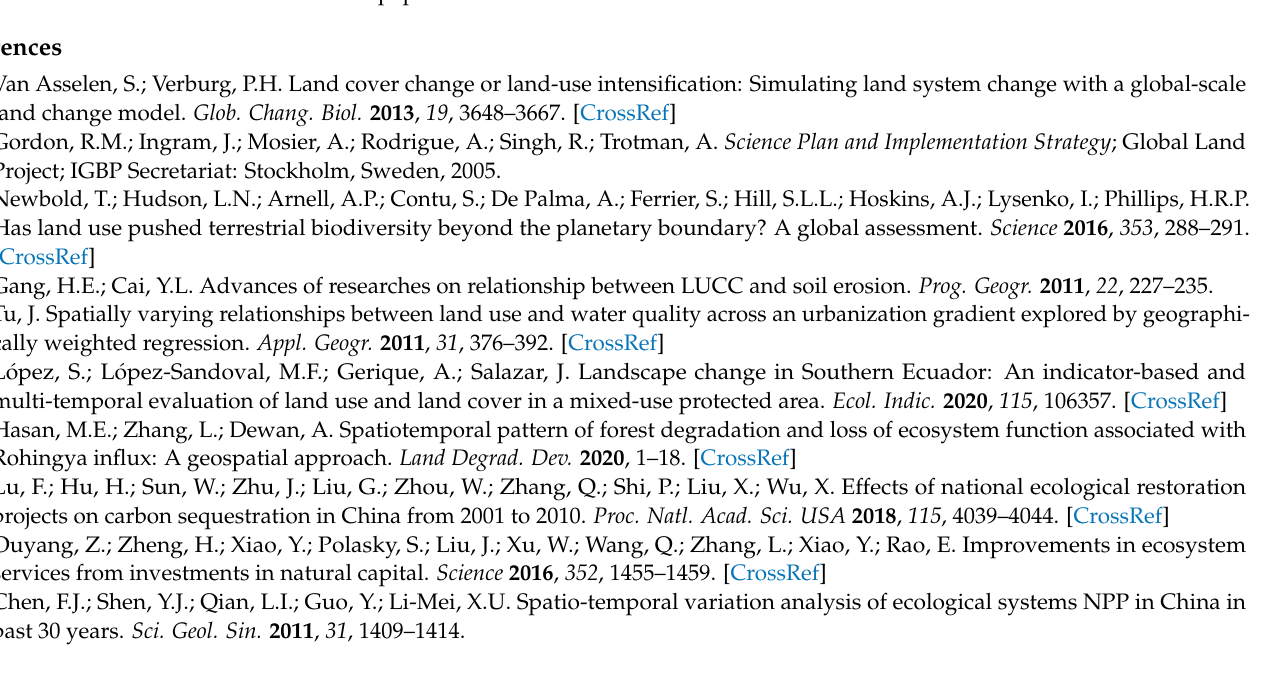
AUC values of land systems, Table S3: Order of conversion of land systems and services, Table S4: Coefficient of simulation accuracy of different land systems, Figure S1: Land conversion under different future scenarios, Figure S2: Spatial distribution of changes in land system from 2000 to